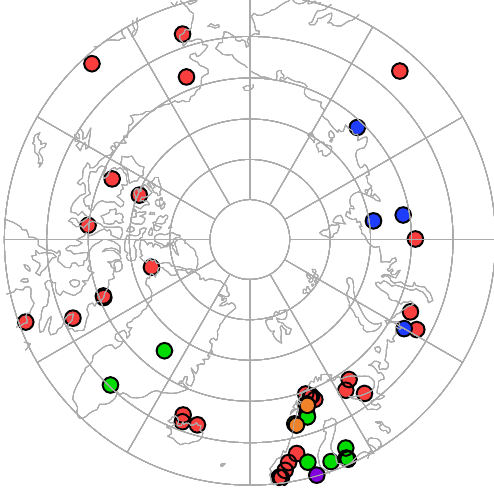
Fig. 1. Locations of the temperature reconstructions from proxy data from high latitudes (60 ◦ N north). There are 46 summer tem- perature, 6 winter temperature and 20 annual mean temperature re- constructions, from in total 61 sites. Red circles denote proxies for summer temperature only. Green circles: proxies for the annual mean temperature. Blue circles: sites with proxies for both summer, winter and annual temperature. Orange circles: summer and winter temperature. Purple circles: summer and annual mean